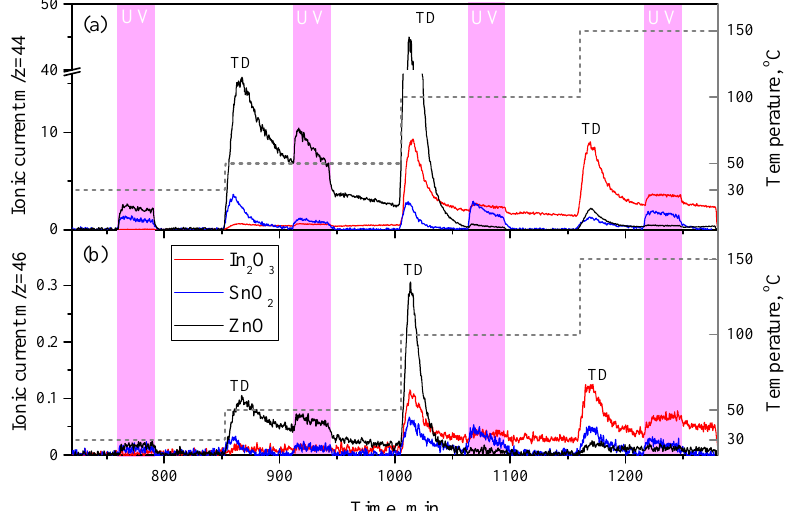
Figure 5. MS analysis of the content of carbon dioxide molecules C 16 O 16 O (44 a.m.u.) ( a ) and C 18 O 16 O (46 a.m.u.) ( b ) in the carrier gas passed through the cell with metal oxide tablets (ZnO, In 2 O 3 , SnO 2 ) and the effect of UV irradiation on their concentration at temperatures of 30, 50, 100, and 150 ◦ C. ( a ) is broken on the intensity axis from 16 to 40 a.u. Thermally activated desorption of CO 2 is marked by “TD”